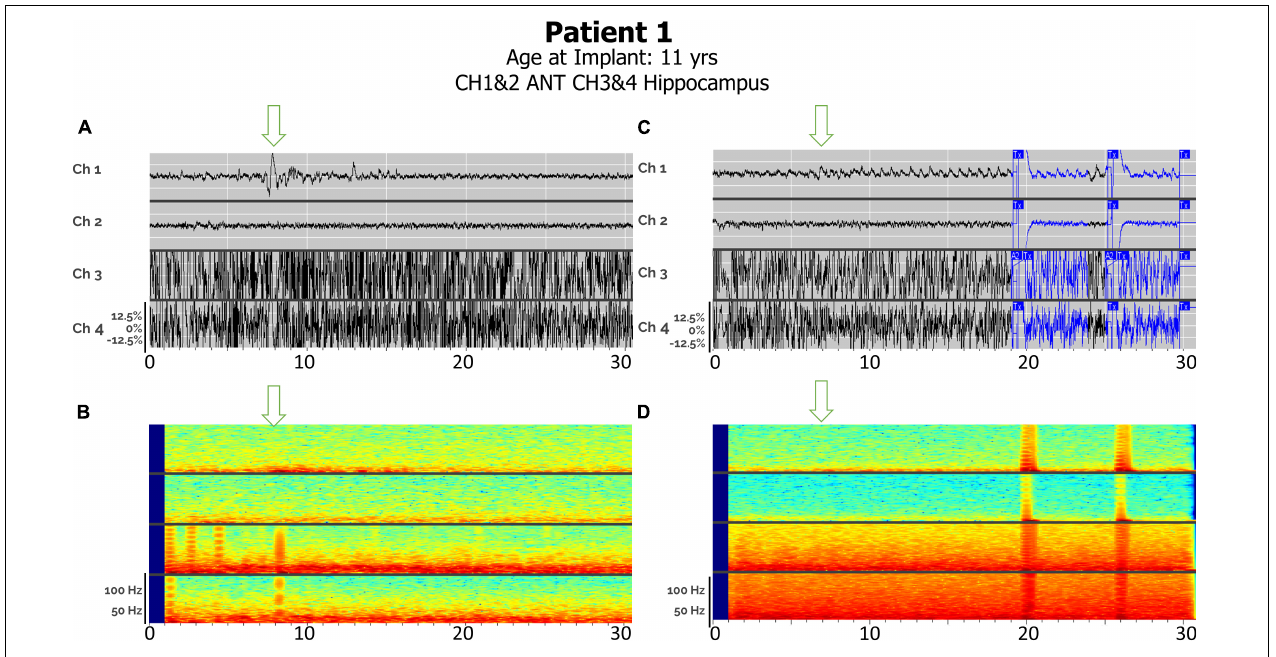
FIGURE 5 | (A) Electroclinical detection of a focal sensory seizure over a 30-s window in Patient #1, with arrows denoting seizure onsets in thalamic lead after seizure onset in hippocampus has already started. Ch 1. R-ANT1–R-ANT2; Ch 2. R-ANT3–R-ANT4; Ch 3. L-Hip–1–L-Hip2; Ch 4. L-Hip3–LHip4). (B) Spectrogram of same epoch. (C) Electroclinical seizure detection and treatment of generalized tonic clonic seizure pattern over a 30-s window with L-Hippocampus onset already started prior to this clip but note thalamic seizure activity onset by the arrow. (D) Spectrogram of same epoch. Tx, therapy; T–c, Charge